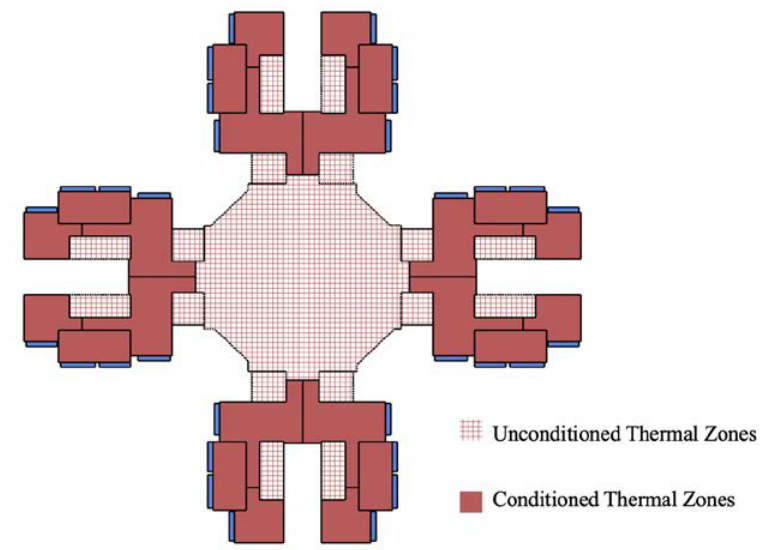
Figure 1. Typical floor layout and modelled thermal zones.